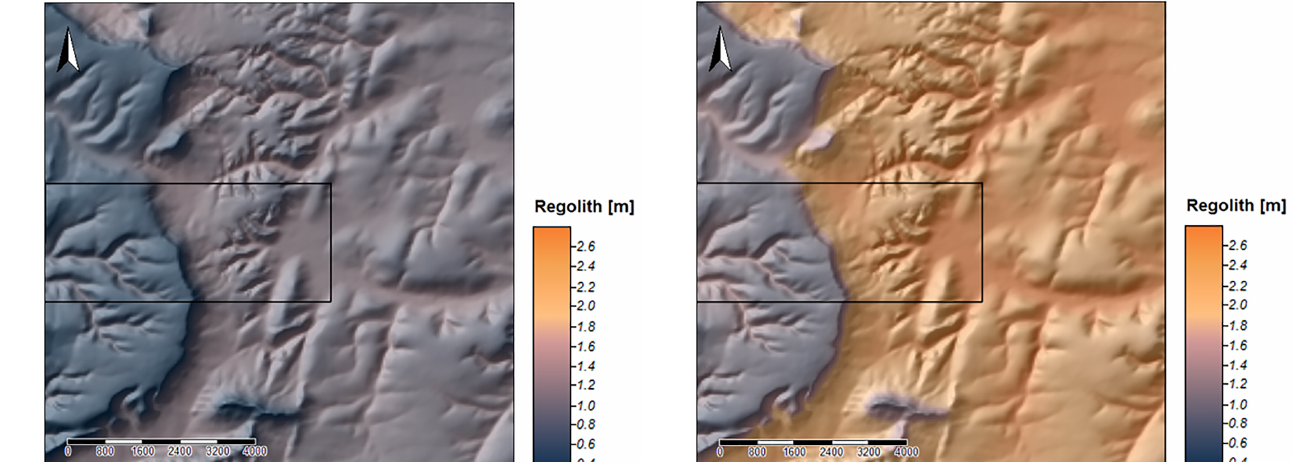
general picture is shown by all of the three variants; in detail, the three variants differ significantly.